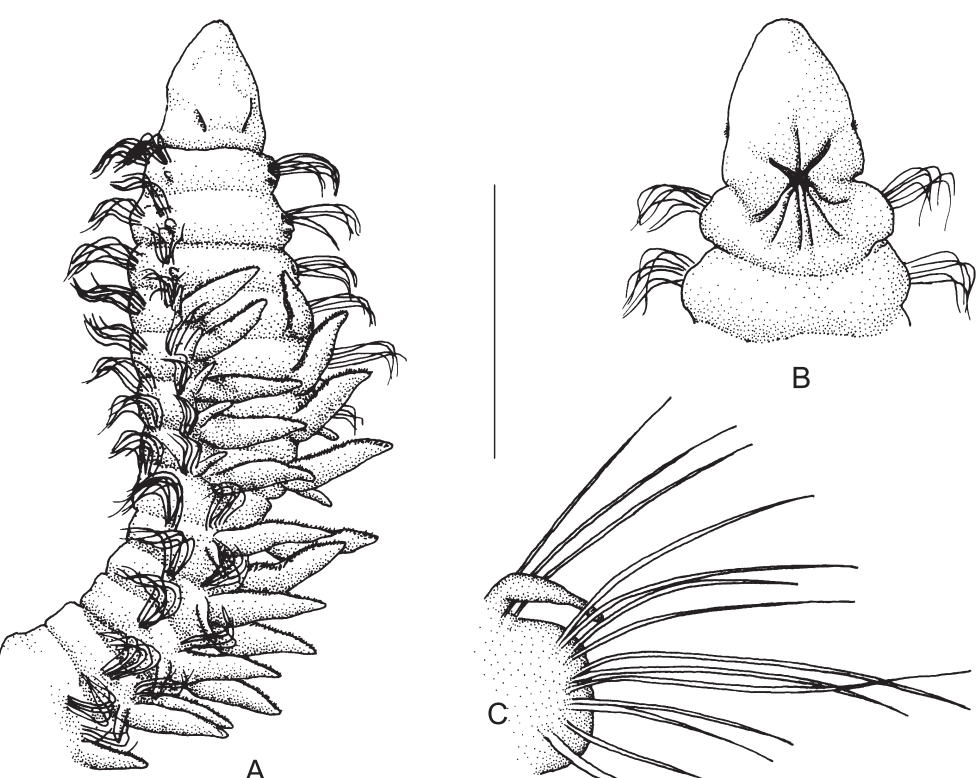
Fig . 9. – Paradoneis eliasoni : A, anterior region, dorsolateral view; b, anterior region, ventral view; c, parapodium, chaetiger 50. Scale bar: A 405 µ m; b 365 µ m; c 110 µ